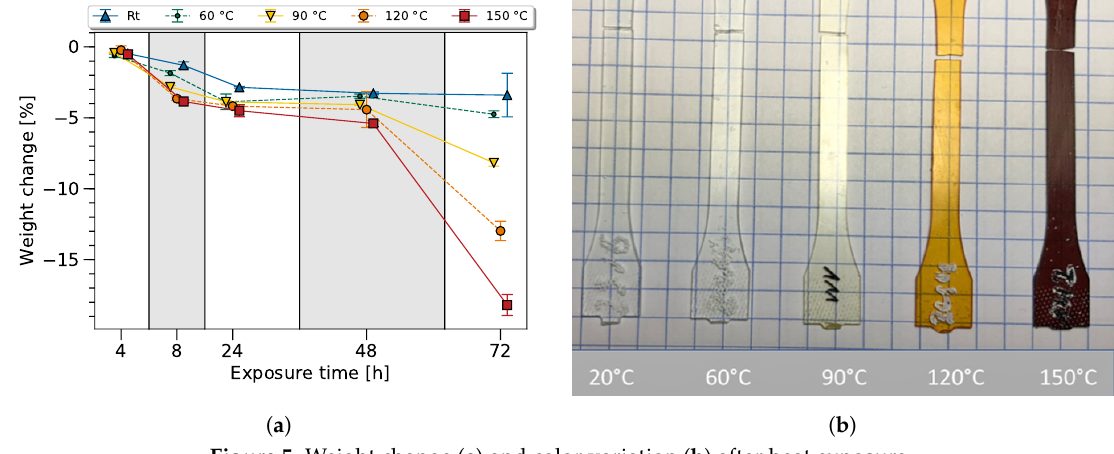
Figure 5. Weight change ( a ) and color variation ( b ) after heat